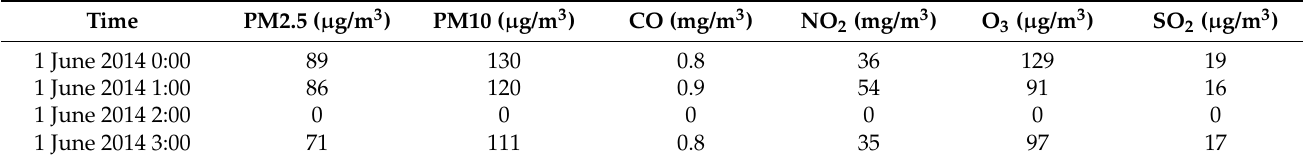
Figure 1. Geographical location of monitoring point. Table 1. Data